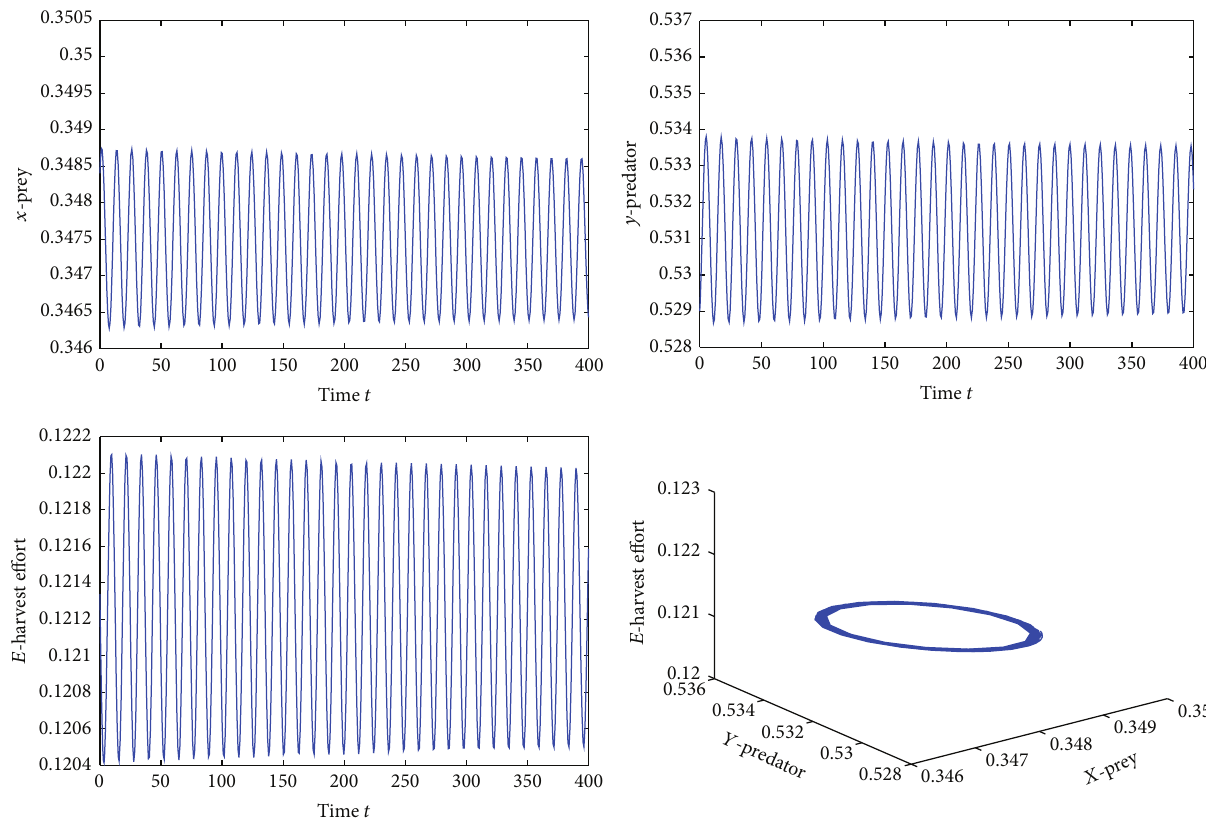
Figure 2: Periodic solutions bifurcating from 𝑋 0 (𝜇) when 𝜇 = 0.164 < 𝜇 0